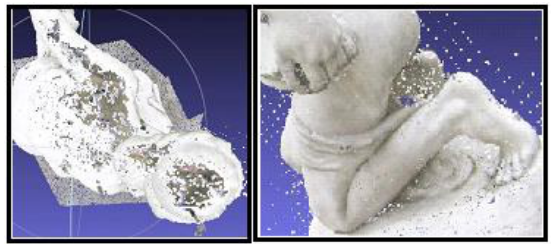
Figure 18. Top view of the Monument- Undeveloped Areas (Left), Details hands and feet of the monument